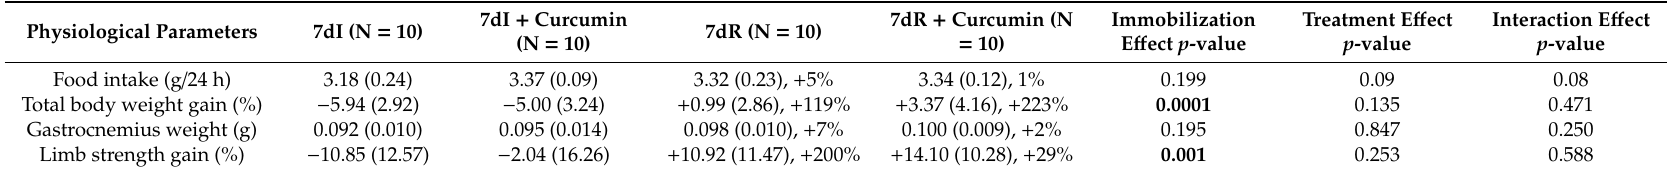
Table 1. Physiological parameters in all experimental groups of mice.